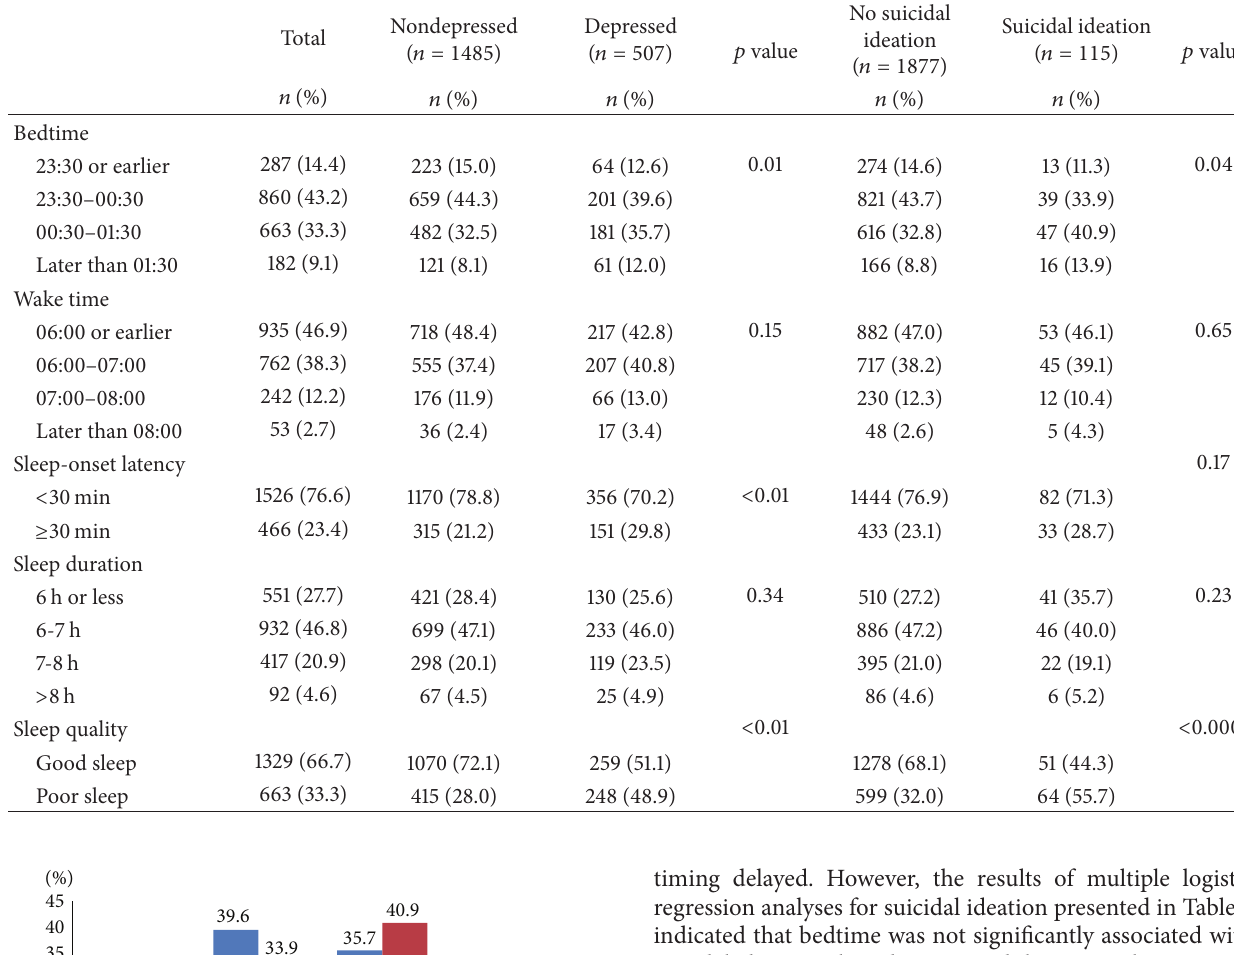
Table 2: Sleep behaviours according to depressive symptoms and suicidal ideation.